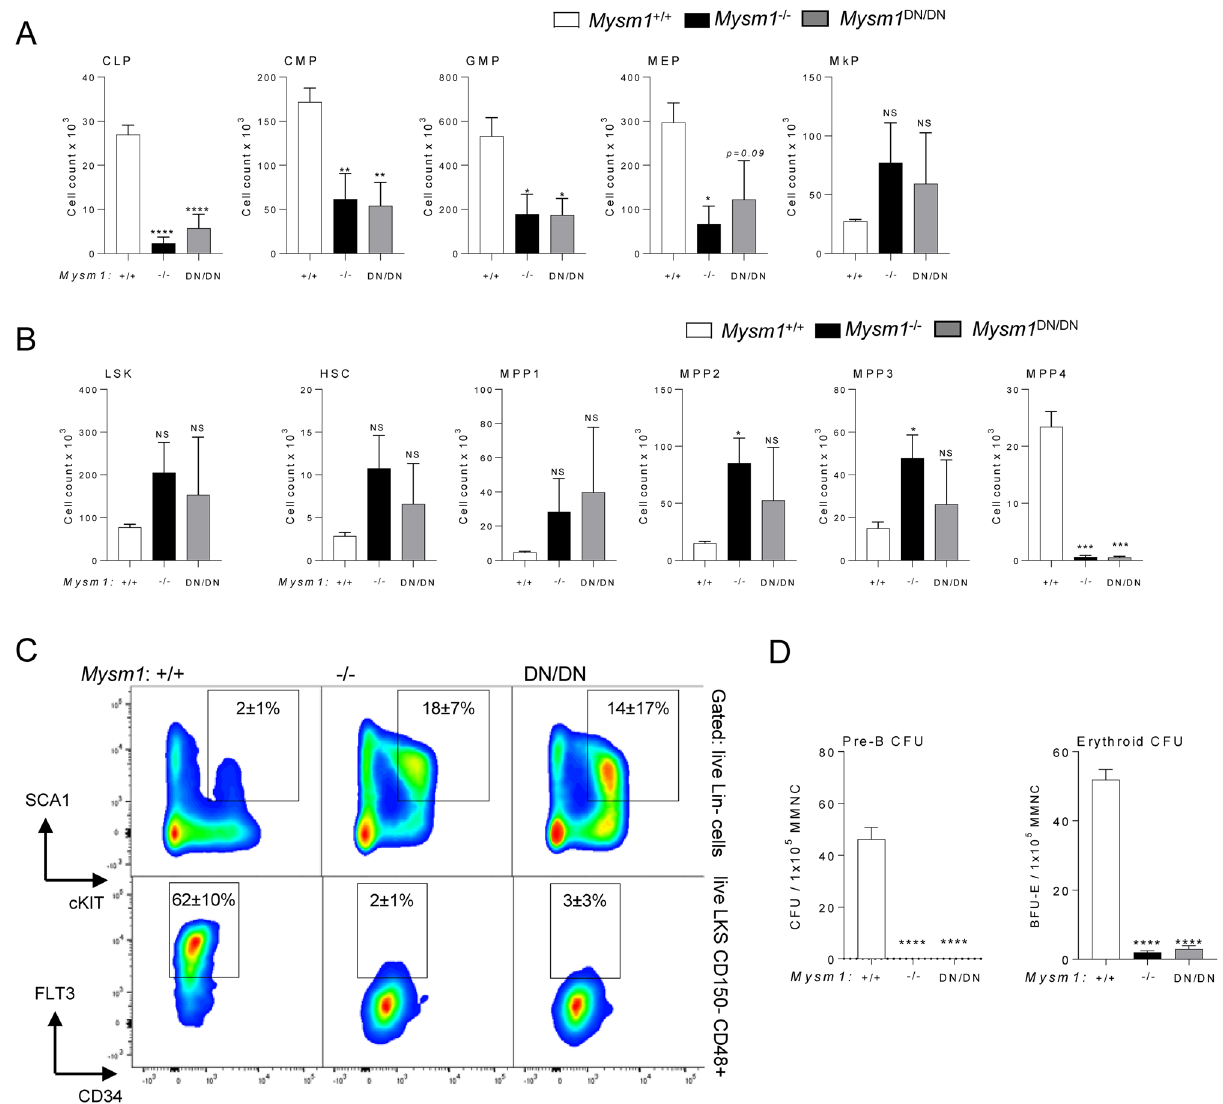
Figure 5. Hematopoietic dysfunction and altered hematopoietic progenitor cell numbers in Mysm1 DN/ DN mice. Flow cytometry analyses were performed on the bone marrow of Mysm1 +/+ , Mysm1 −/− , and Mysm1 DN/DN mice to quantify ( A ) common lymphoid progenitors (CLP, Lin − IL7Rα + cKit lo Sca1 lo ), common myeloid progenitors (CMP, Lin − cKit + Sca1 − CD34 + CD16/32 − ), granulocyte monocyte progenitors (GMP, Lin − cKit + Sca1 − CD34 + CD16/32 + ), megakaryocyte erythroid progenitors (MEP, Lin − cKit + Sca1 − CD34 − CD16/32 − ), and megakaryocyte progenitors (MkP, Lin − cKit + Sca1 − CD150 + CD41 + ); ( B ) hematopoietic stem cells (HSCs) and multipotent progenitors (MPP1-4), gated as LSK (Lin − cKit + Sca1 + ), followed by CD150 + CD48 − CD34 − Flt3 − for HSCs, CD150 + CD48 − CD34 + Flt3 − for MPP1, CD150 + CD48 + CD34 + Flt3 − for MPP2, CD150 − CD48 + CD34 + Flt3 − for MPP3, and CD150 − CD48 + CD34 + Flt3 + for MPP4. The data is from 3–10 mice per genotype consolidated from two independent experiments. Bars represent means ± SEM; statistical analysis with ANOVA and Dunnett’s post-hoc test, comparing each group to the control, * p < 0.05, ** p < 0.01, *** p < 0.001, **** p < 0.0001, NS—not significant; bone marrow cell counts are presented per two tibias and femurs. ( C ) Representative flow cytometry density plots of the bone marrow of Mysm1 +/+ , Mysm1 −/− , and Mysm1 DN/DN mice, gated on live Lin- cells and showing the LSK cell population (top), or gated on the LSK C150 − CD48 + cells and showing the Flt3 lo MPP3 and Flt3 hi MPP4 cells; the average frequency of cells in the gates is presented as mean ± st. dev. While the LSK cell numbers are highly variable (top), a strong depletion of the lymphoid-primed MPP4 cells is consistently observed in all the Mysm1 −/− and Mysm1 DN/DN mice (bottom). ( D ) Colony forming units (CFU) assays showing depletion of pre-B and erythroid BFU-E progenitors in Mysm1 DN/DN and Mysm1 −/− mouse bone marrow; MMNC – marrow mononuclear